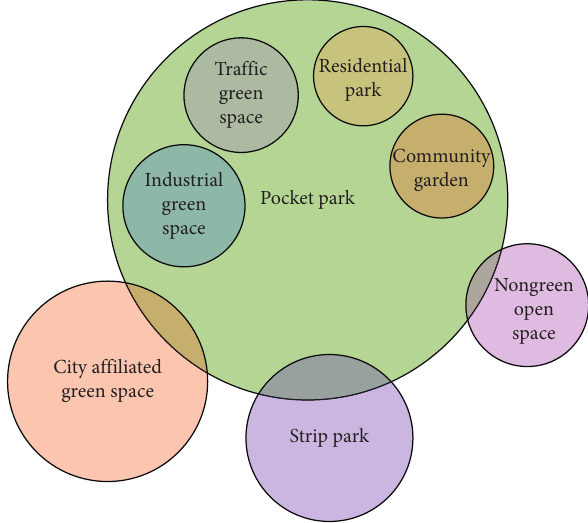
Figure 1: The scope of pocket